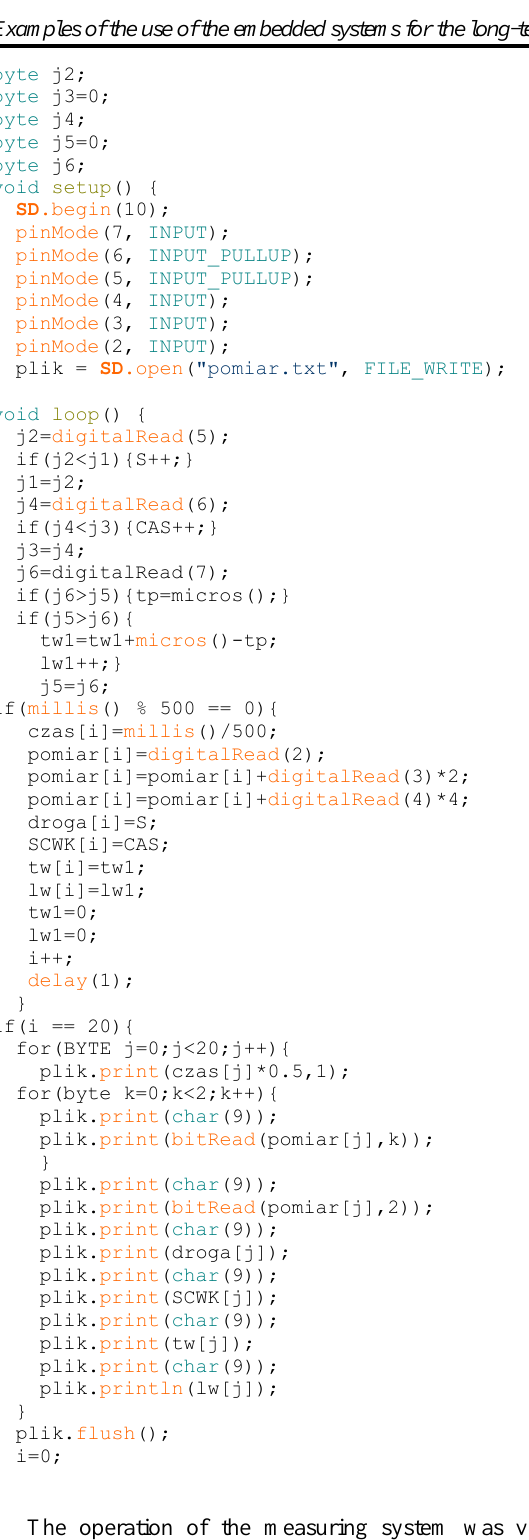
Fig. 12. The waveform of the changes in the rotational speed of the engine and the average injection time in half-second periods The graph in Fig. 12 shows, inter alia, average injection times in half-second measurement periods. Due to the oc- currence of many injections in one measuring period, it